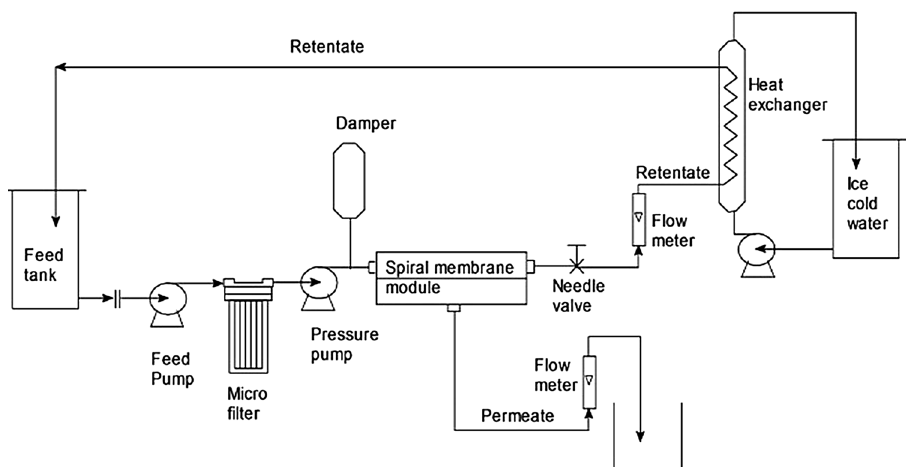
Fig. 3 Schematic view of the experimental nanofiltration mini pilot plant (Rao et al. 2012)